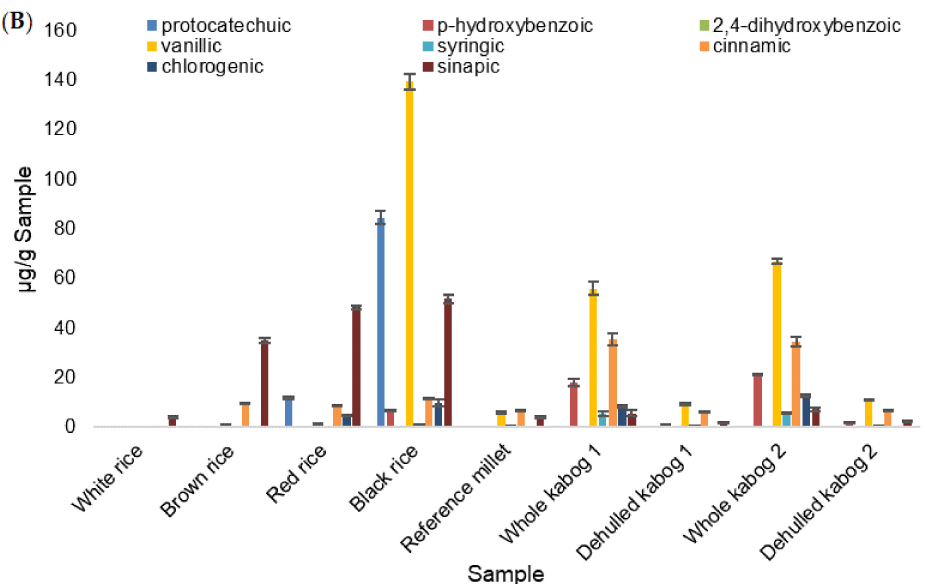
Figure 3. ( A ) Ferulic and p -coumaric acid content of rice (white, brown, red, and black), reference millet, and kabog millet (whole and dehulled) samples. ( B ) Individual phenolic acid content ( µ g / g sample) of rice (white, brown, red, and black), reference millet, and kabog millet (whole and dehulled) samples, not including p -coumaric and ferulic acids. Values with the same letters are not significantly di ff erent at p < 0.05 using one-way ANOVA Tukey’s